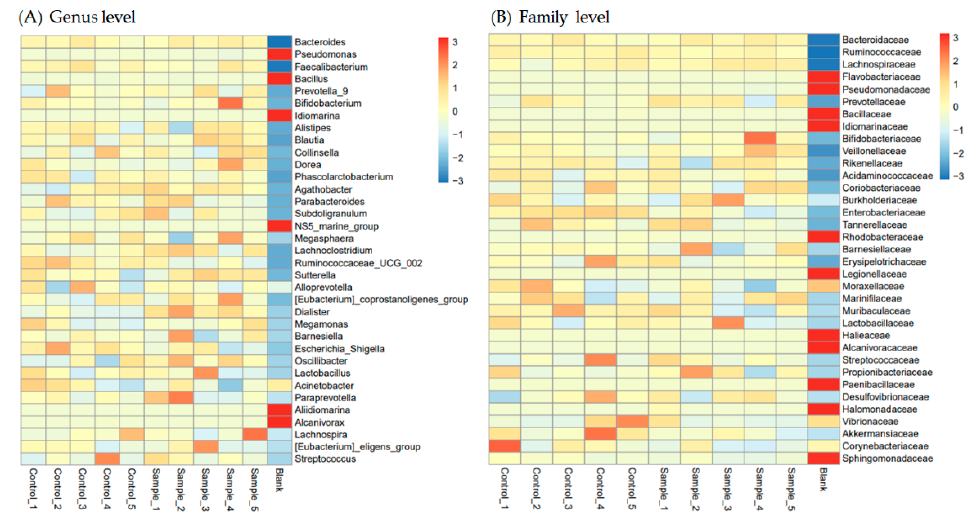
Figure 5. Heatmap of intestinal microbiota in L. vannamei shrimp. According to the species annotation and abundance information of all samples in the ( A ) genus level and ( B ) family level, we selected the top 35 in abundance.